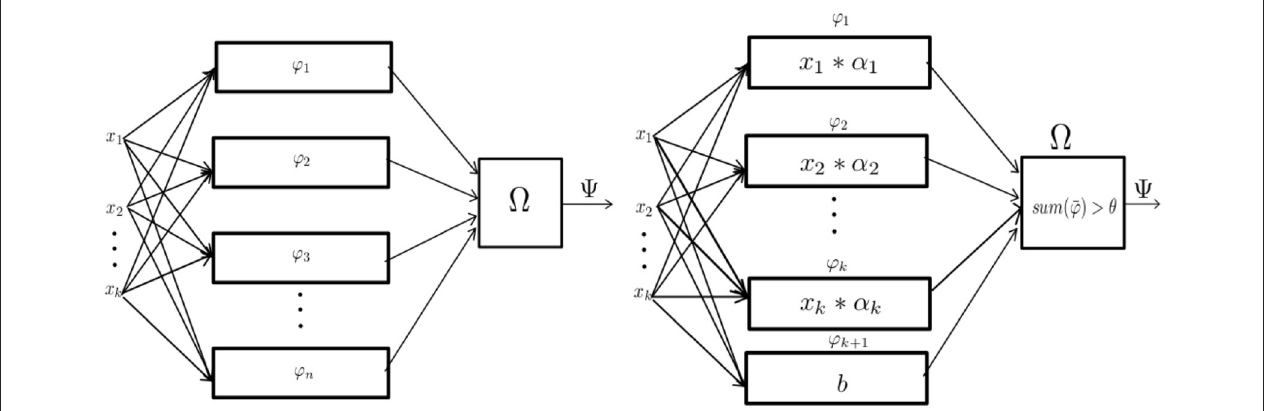
FIGURE 1 | From left to right: The abstract definition of parallel machine and the perceptron as a parametric implementation of the parallel machine. Figures based on the diagrams depicted in the book Perceptrons (Minsky, 1969).